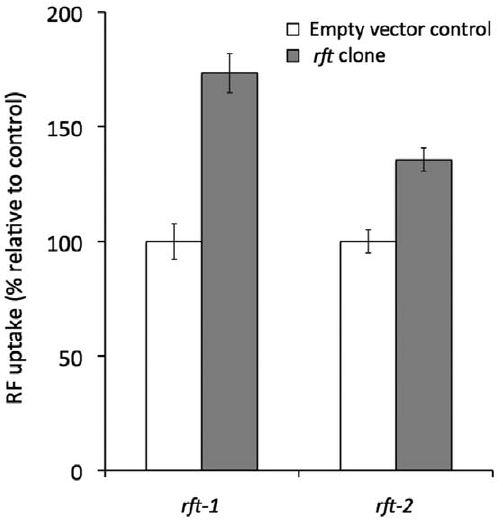
Figure 2. Functional identification of the cloned rft -1 and rft -2 as a specific riboflavin transporter in ARPE-19 cells. Confluent ARPE-19 cells expressing rft-1 and rft-2 were incubated with [ 3 H] riboflavin (14 nM; 5 min at 37 u C in Krebs-Ringer buffer, pH 5.5). Carrier mediated uptake was determined as described in the methods section. Induced uptake by the riboflavin transporter was determined by subtracting uptake in empty-vector transfected cells from the cells transfected with the rft -1 and rft -2 constructs and are expressed as means 6 SE.